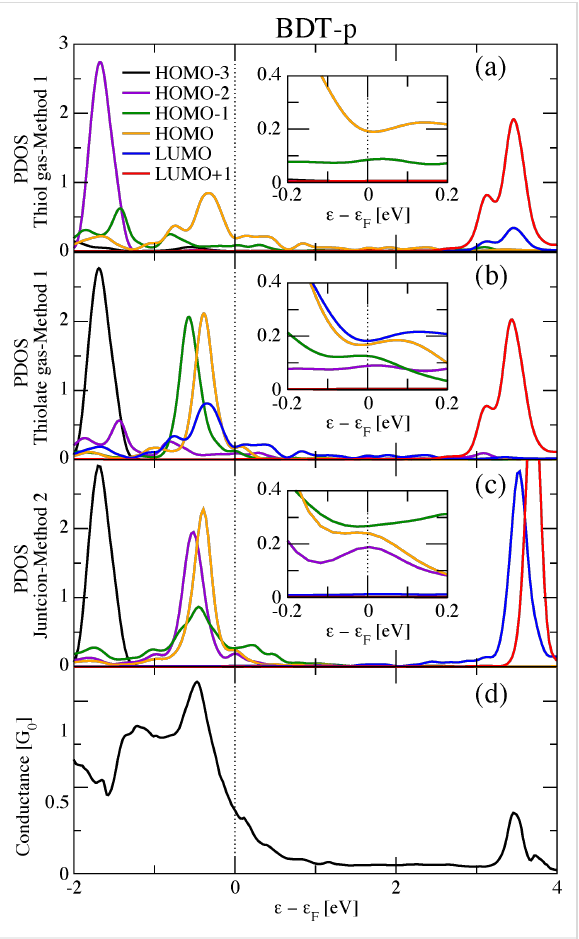
Figure 5: Projected density of states (a,b,c) and conductance (d) of benzene-dithiol in the pyramidal geometry (BDT-p). The PDOS for the different molecular orbitals (from HOMO − 3 to LUMO+1) were obtained with (a) Method 1 based on the dithiol molecule, (b) Method 1 based on the dithiolate molecule, and (c) Method 2 (see text). The insets show details of the PDOS around the Fermi energy region.